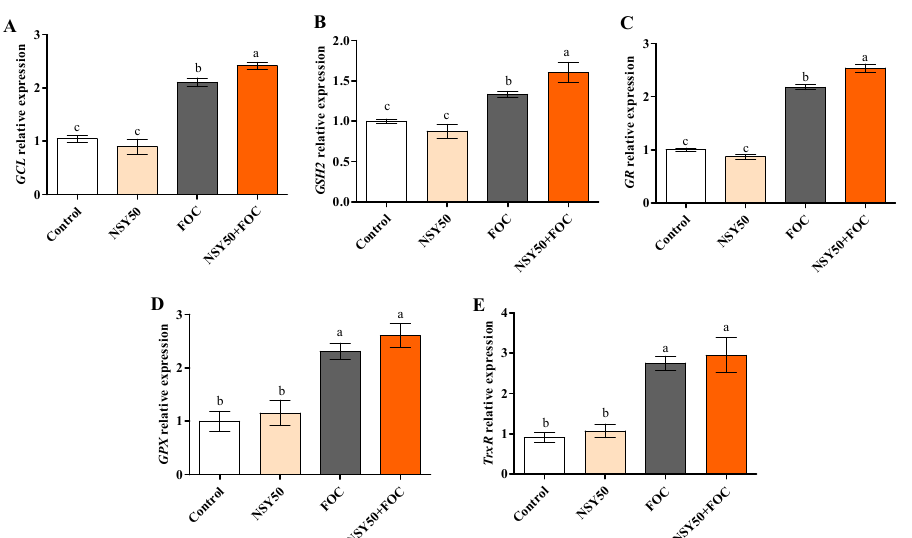
Figure 6. Expression of GSH biosynthesis and metabolism related genes in cucumber roots. ( A ) ex- pression of γ-glutamylcysteine ligase, GCL ; ( B ) expression of glutathione synthetase, GSH2 ; ( C ) ex- pression of glutathione reductase, GR ; ( D ) expression of Glutathione peroxidas, GPX ; ( E ) expression of Thioredoxin reductase, TrxR . Root samples were harvested at three days post-inoculation (dpi) with FOC in different treatments. Each value is means ± SE of three independent experiments. Values are the means ± SD, n = 3 (biological replicates), and different letters (a > b > c) indicate a significant difference at p < 0.05, as determined by Duncan’s multiple-range test.